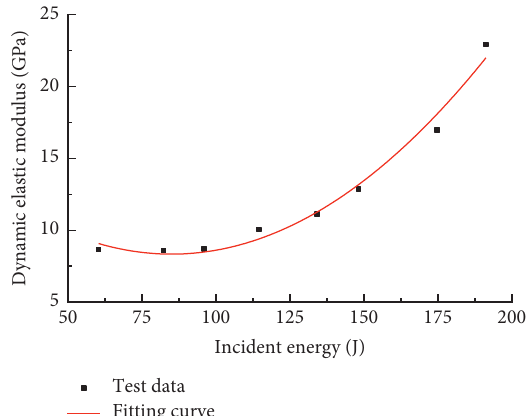
Figure 15: Relationship between dynamic elastic modulus and incident energy.